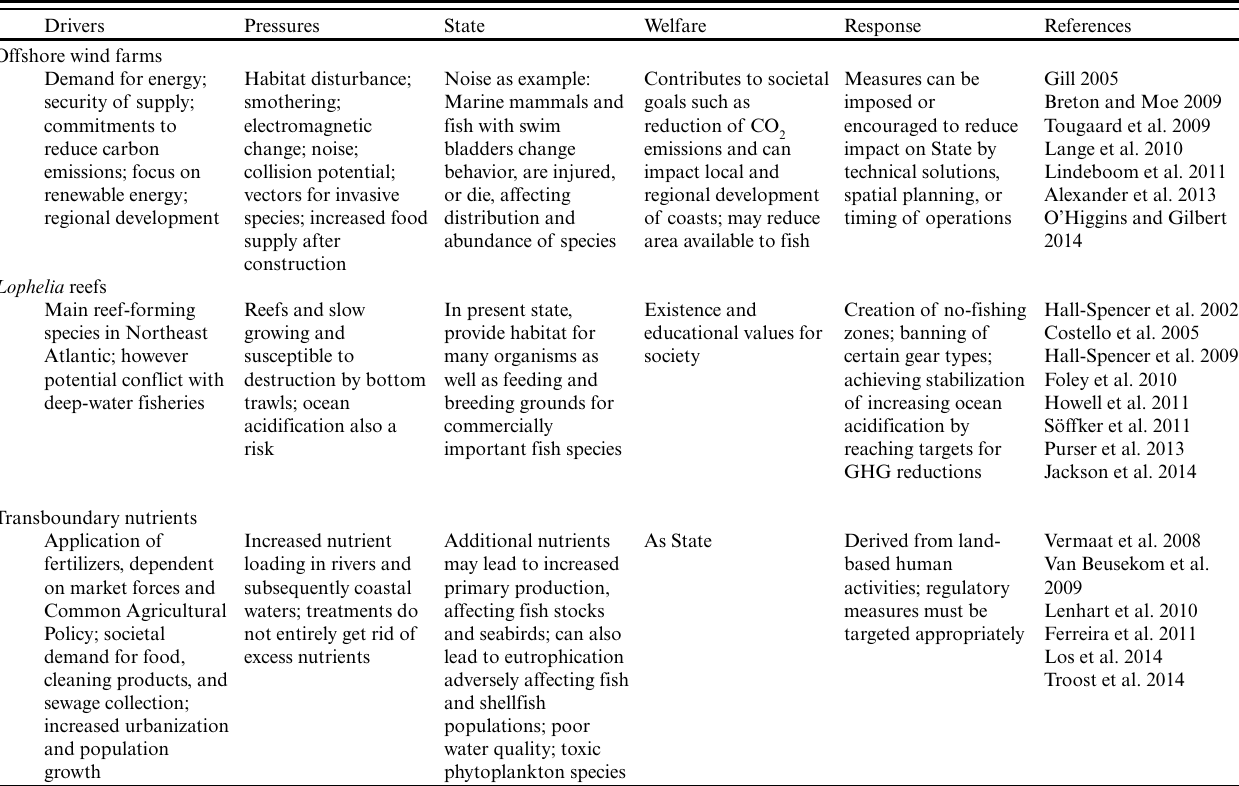
Table 1 . Driver–Pressure–State–Welfare–Response (DPSWR) framework components of each of the three case studies used as the basis for this